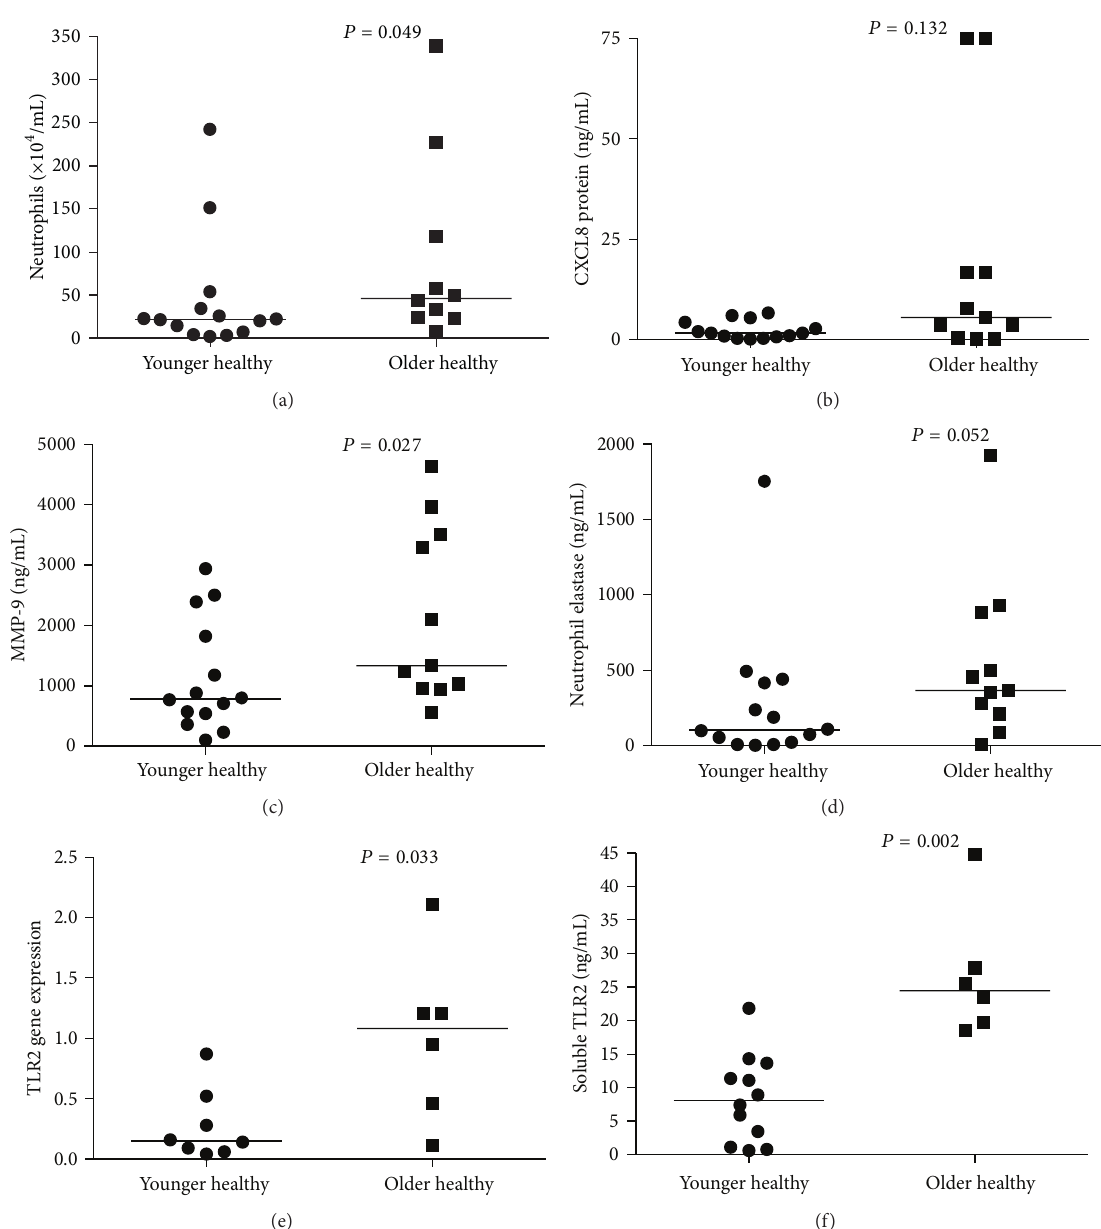
Figure 1: Analysis of the effect of age on markers of neutrophilic inflammation. This analysis used healthy never-smoking controls comparing younger ( < 55 years of age) with older ( > 55 years of age) controls. (a) Neutrophil number × 10 4 /mL, (b) CXCL8 protein ng/mL, (c) MMP-9 protein ng/mL, (d) NE protein ng/mL, (e) TLR2 gene expression, and (f) soluble TLR2